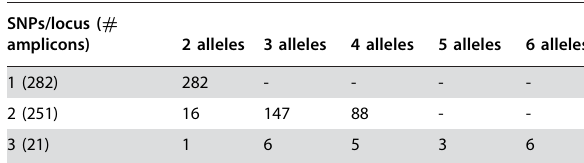
Table 3. Percent population assignment based on